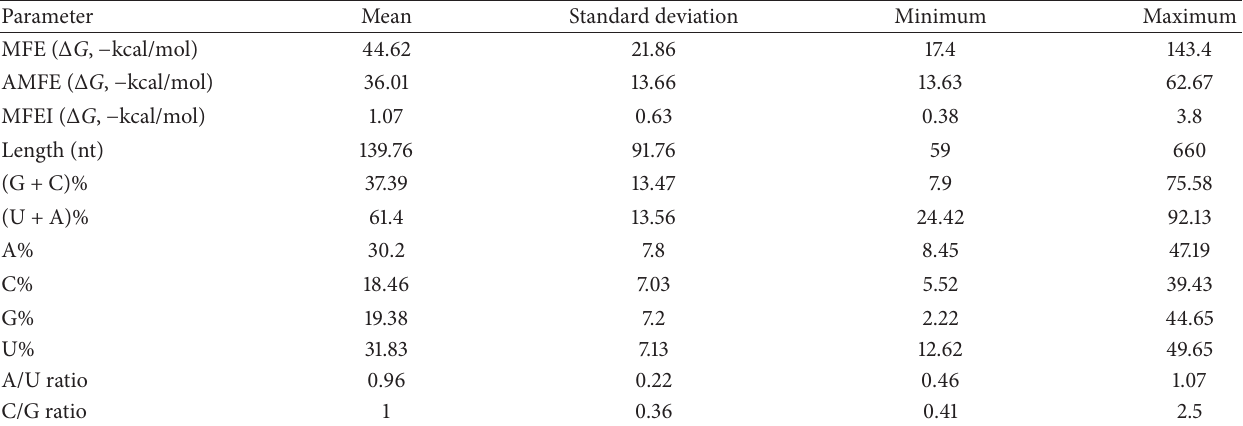
Table 2: Statistics of the characterized parameters of wheat miRNA